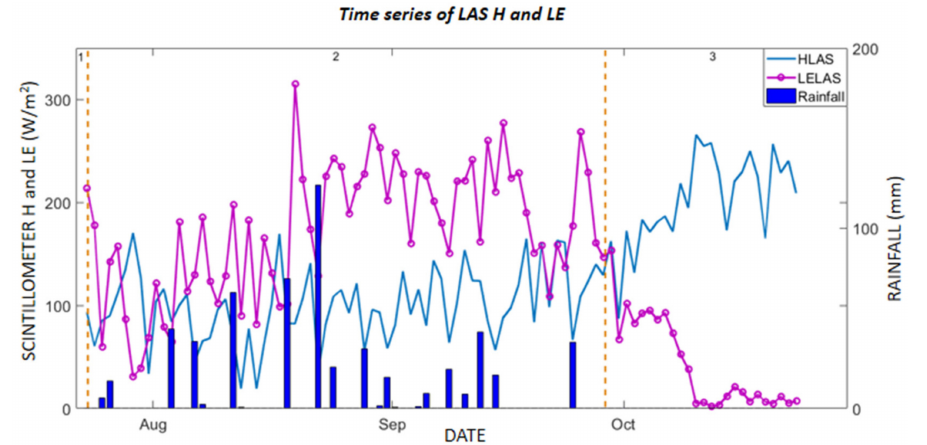
Figure 4. Time series of LAS latent and sensible heat fluxes (daily average between 9:00 a.m. and 5:00